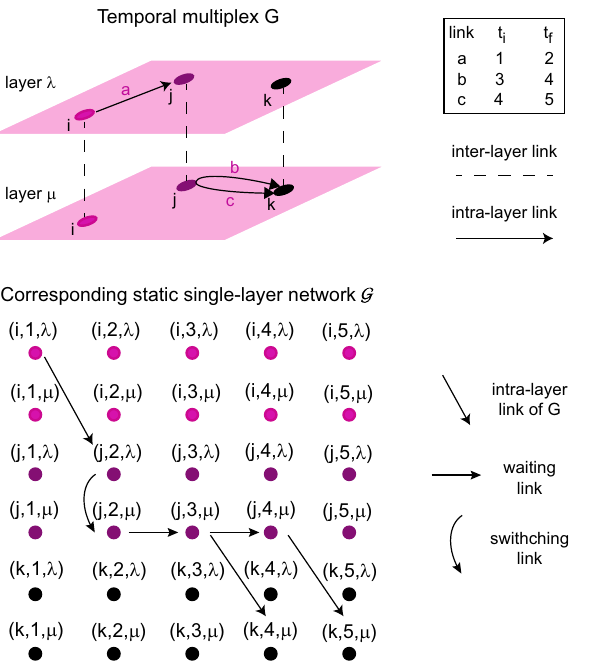
Figure 1. Example of conversion of a temporal multiplex G (above) into the corresponding static single- layer network G (below). G has M = 2 layers and N = 3 nodes, links a , b and c have the temporal structure ( T = 5 ) indicated on the side ( t i is the time-step during which the link appears and t f the one during which it disappears). In G each of the three nodes has 10 copies, one per layer and per time-step of the temporal